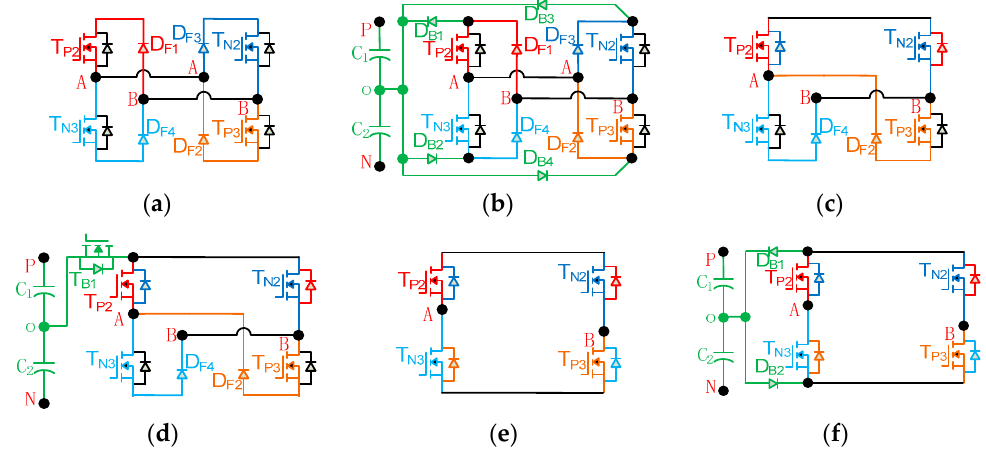
Figure 22. Indirect Connection NPC cell circuits under DFUSPWM. ( a ) case #1; ( b ) NPC cell under case #1; ( c ) case #2; ( d ) NPC cell under case #2; ( e ) case #3; ( f ) NPC cell under case #3.